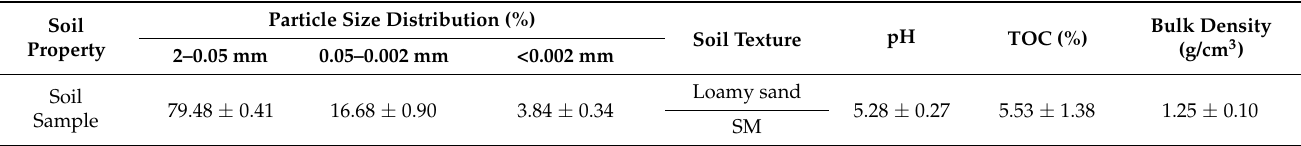
Table 2. Physical and chemical properties of soil